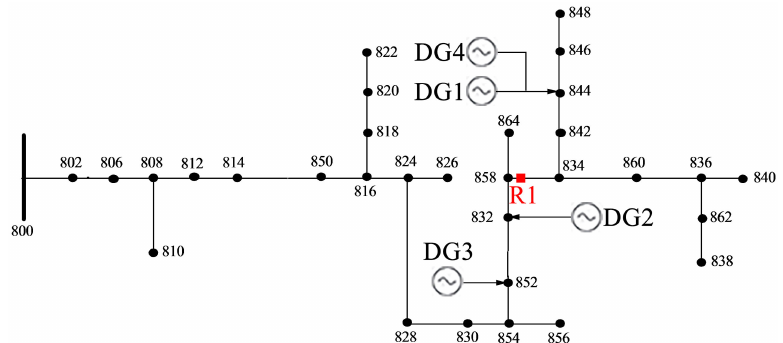
Figure 3. Structure of the IEEE 34-node test distribution